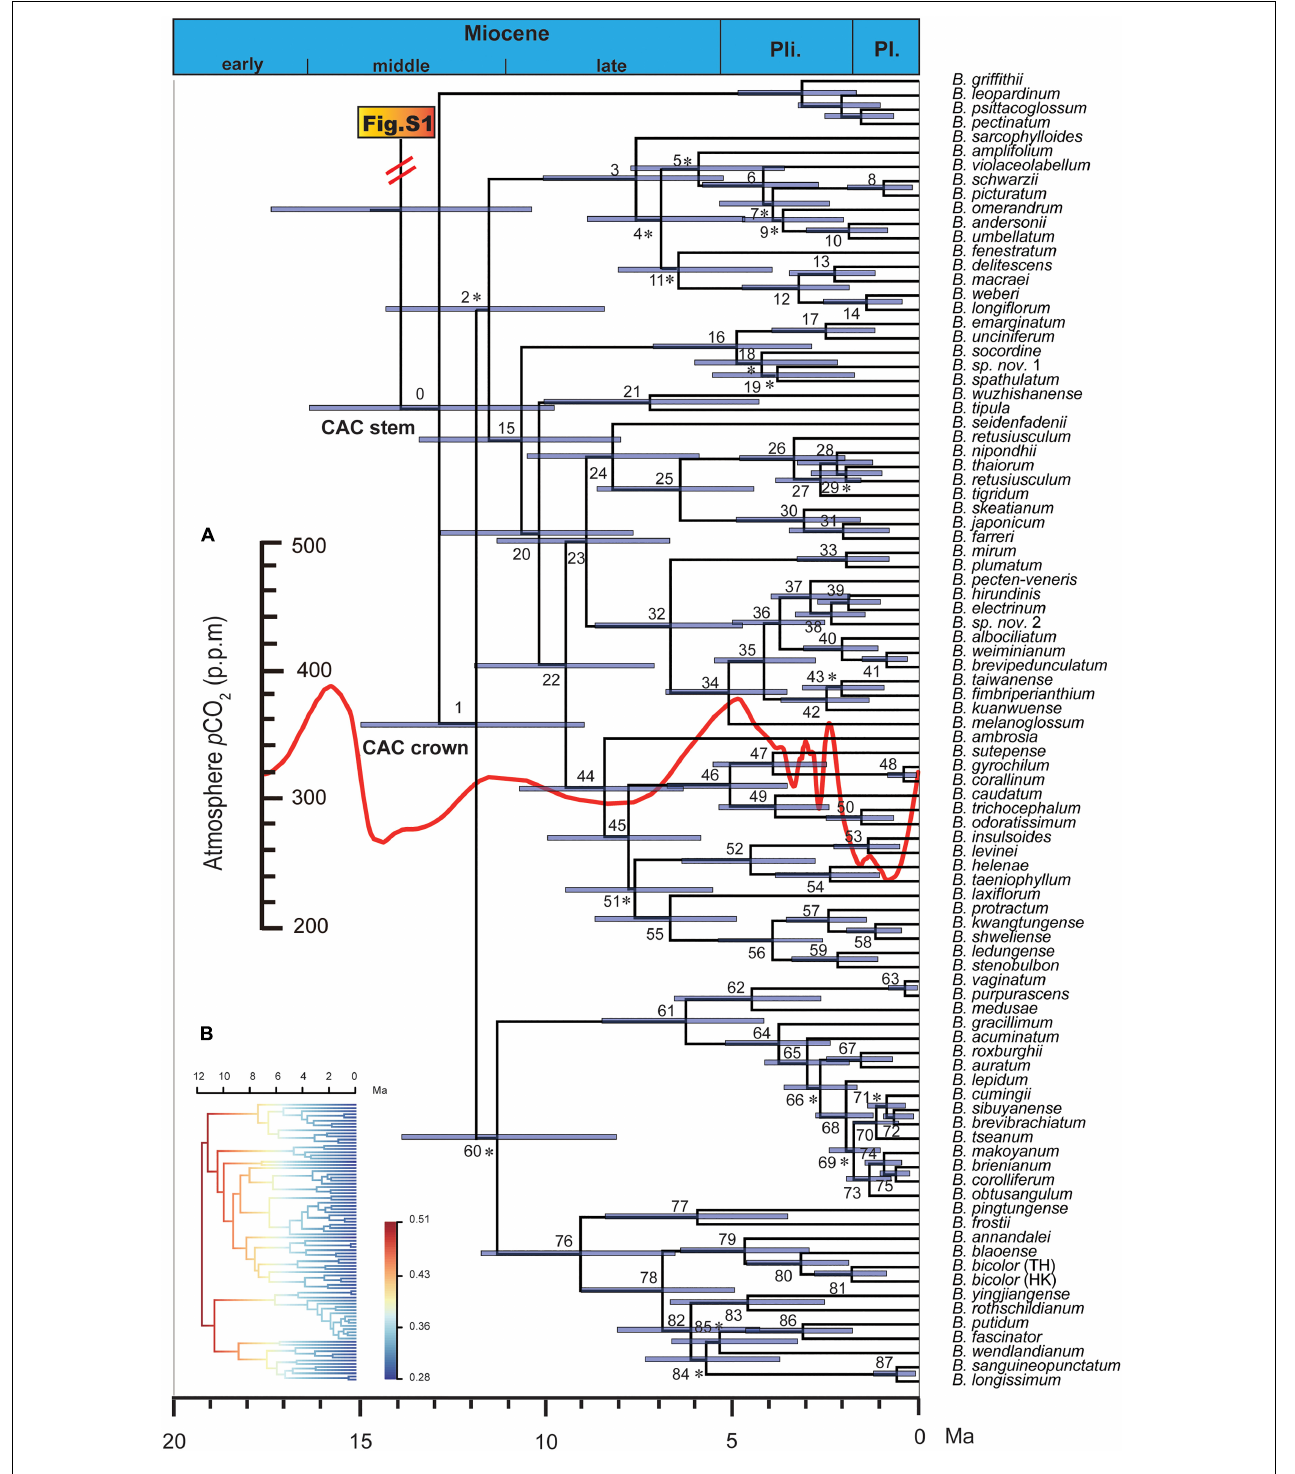
FIGURE 1 | Maximum clade credibility chronogram of the Cirrhopetalum alliance clade (CAC) and its sister group. Asterisk indicates nodes with posterior clade probabilities (PP) < 0.95; otherwise, PP ≥ 0.95. Node numbers correspond with those in Supplementary Table 4 . The inserted curve (A) represents estimated mean atmospheric CO 2 concentration change based on palaeoclimatic p CO 2 data extracted from Foster et al. (2017); the inserted phylorate plot (B) corresponds to the topology of CAC, showing net species diversification rate (lineage/Myr; cool colours = slow, warm = fast). B. , Bulbophyllum ; Ma, million years ago; Pl., Pleistocene; Pli.,